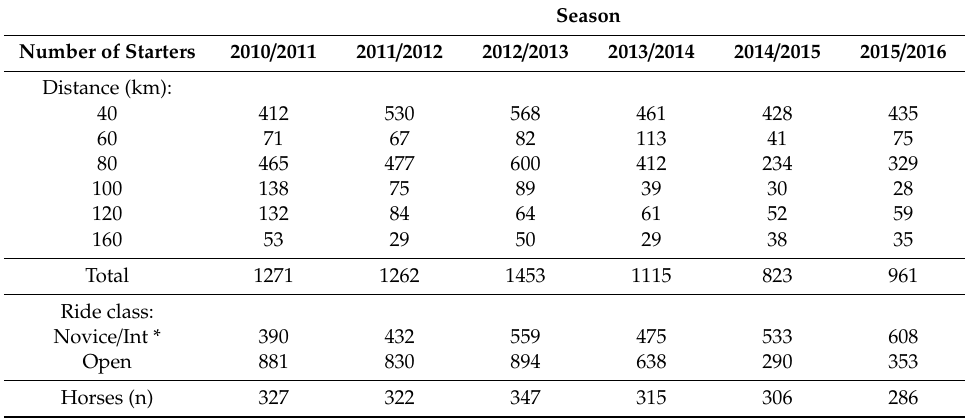
Table 2. Number of starters per season over six endurance competition seasons 2010 / 11–2015 / 6 in New